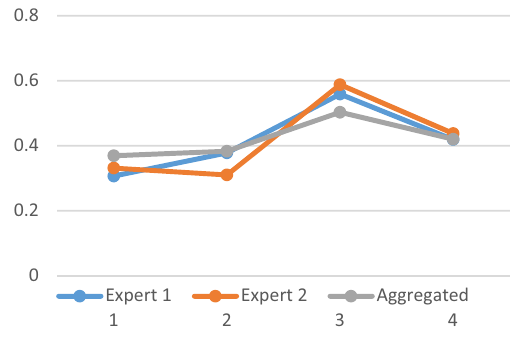
Figure 3. Ranking based on scores.